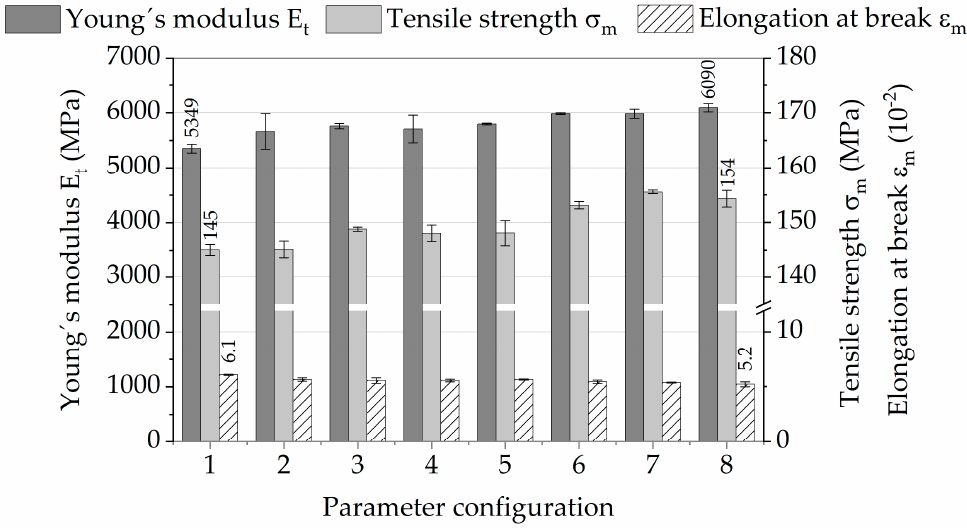
Figure 5. Quasi-static tensile properties of different injection molding parameter configurations.